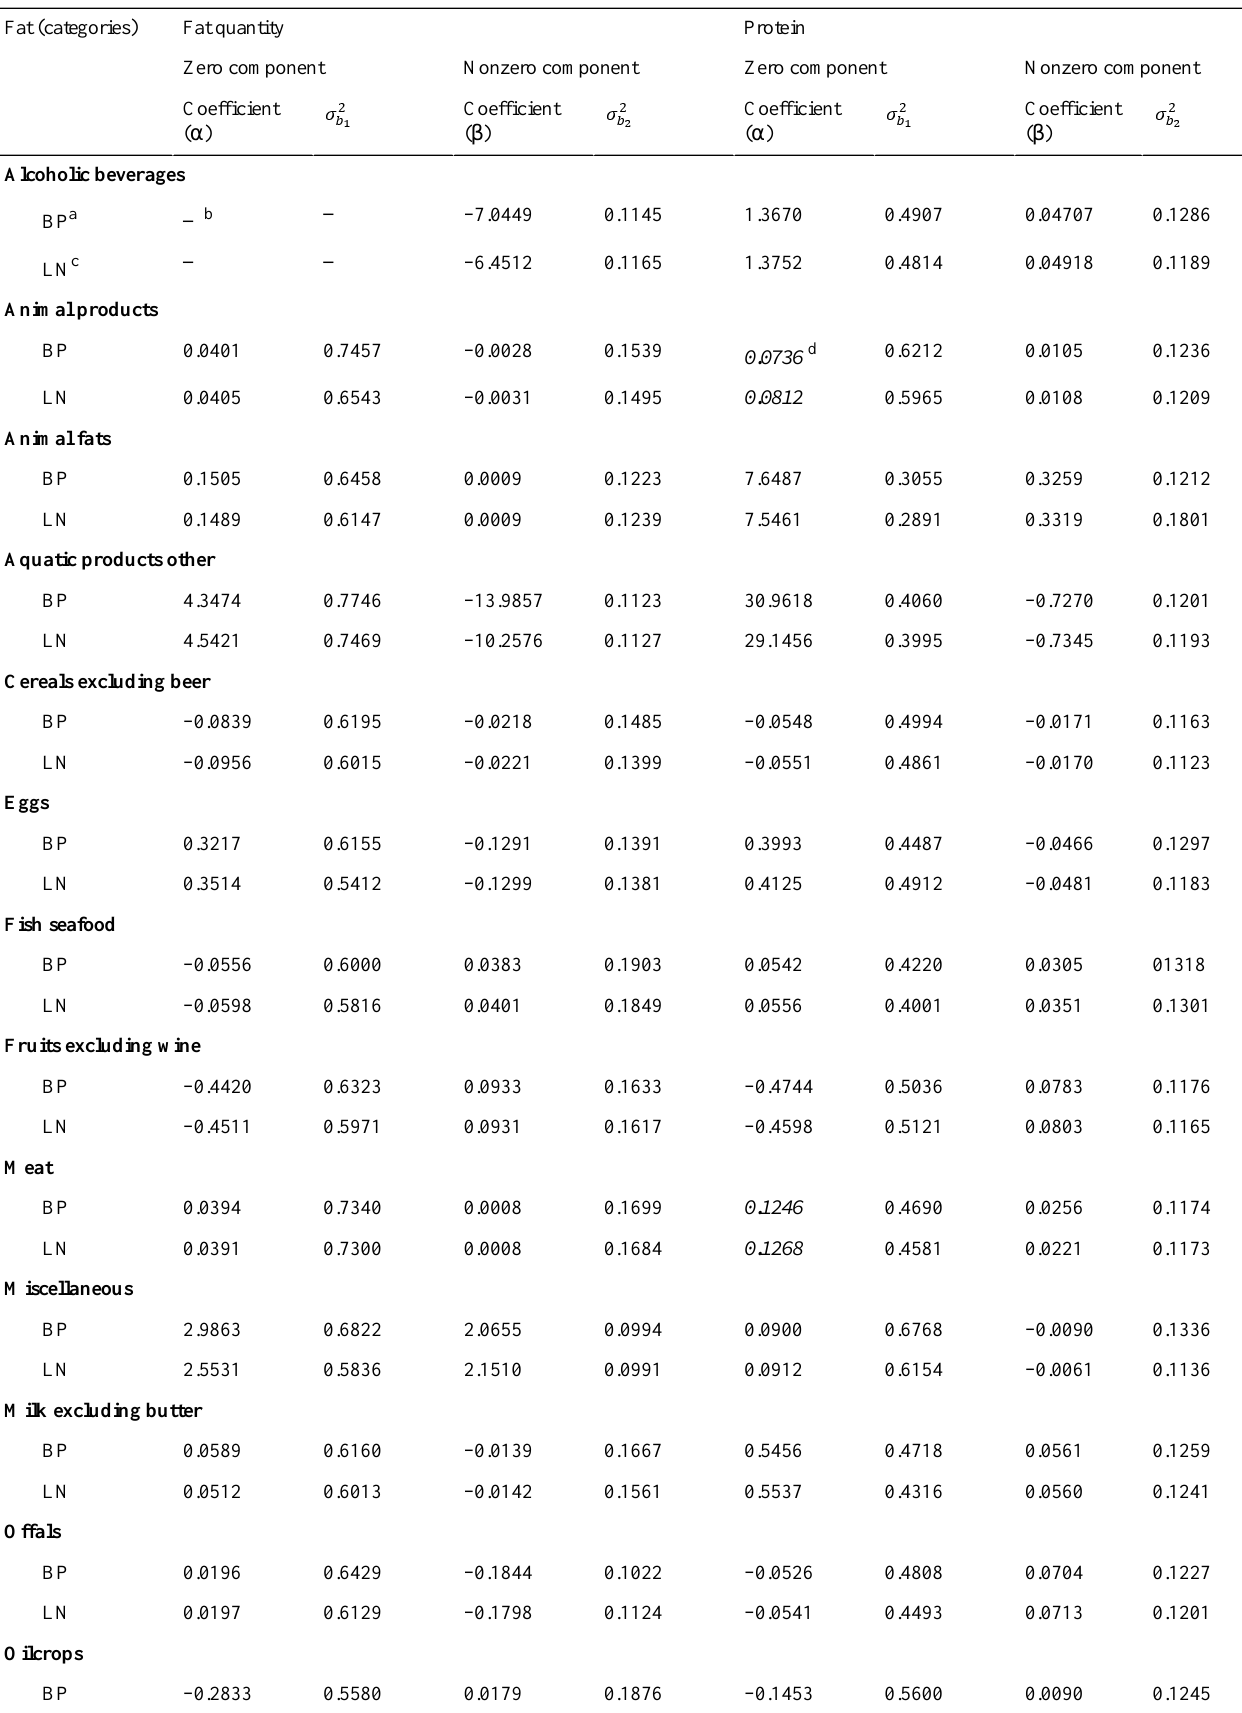
Table 1. Results of marginalized two-part BP and LN model in predicting number of deaths per 100 cases and considering the cluster effect of World Health Organization regions in the fat data